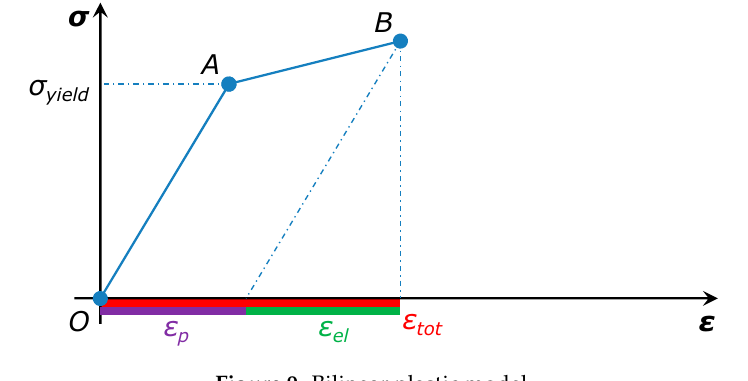
Figure 9. Bilinear plastic model.